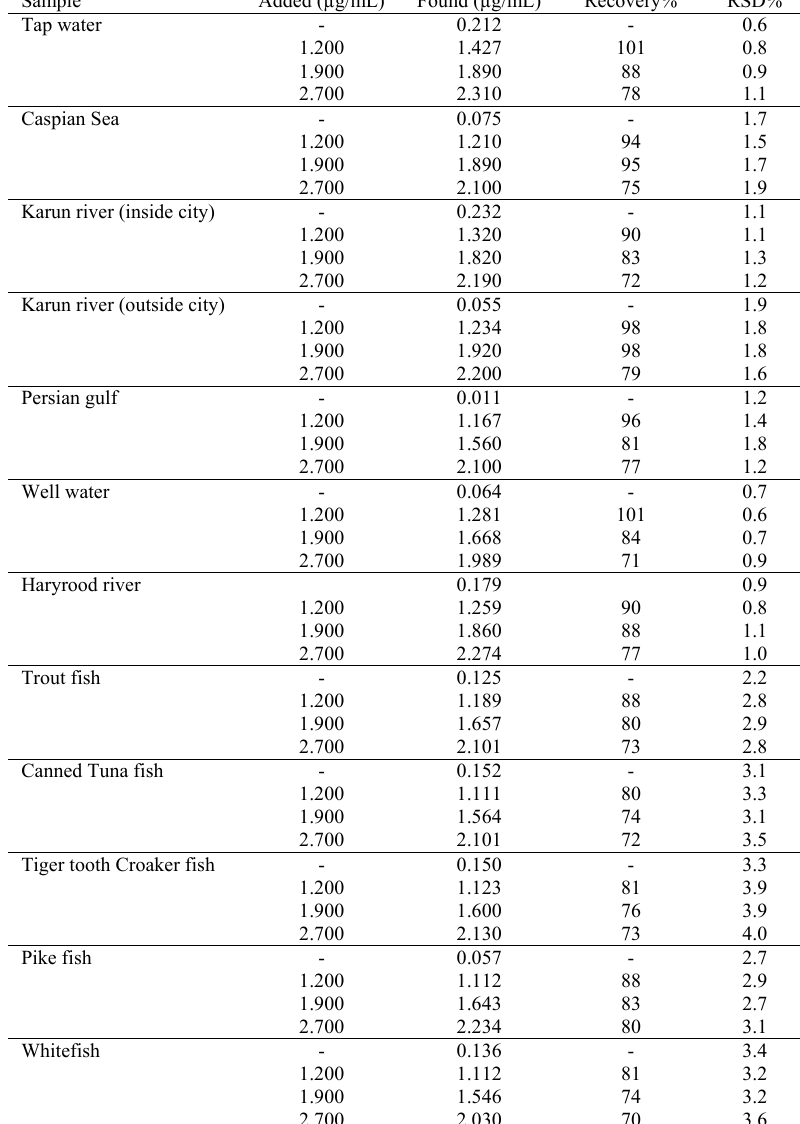
Table 2 Extraction-preconcentration of Hg(II) ions from water and fish samples Table 2. Extraction-preconcentration of Hg(II) ions from water and fish Sample